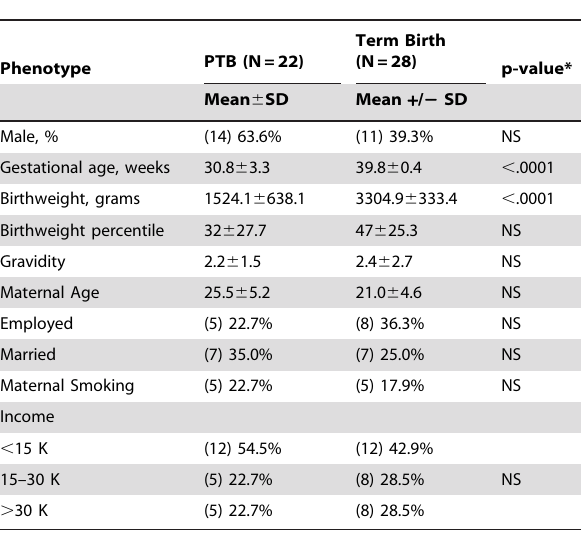
Table 1. Clinical and demographic characteristics of the